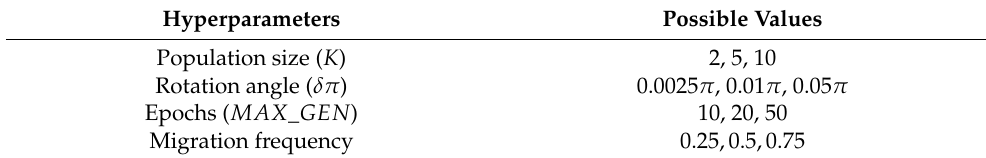
Table 3. Hyper-parameters of and the assigned possible values for the grid search.